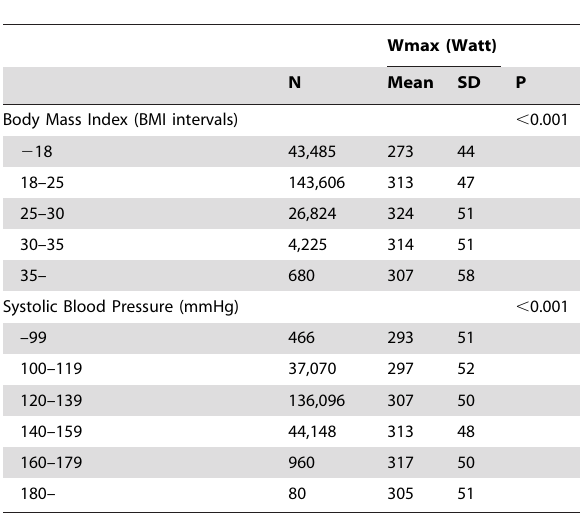
Table 7. Maximal exercise capacity by conscript characteristics (univariate